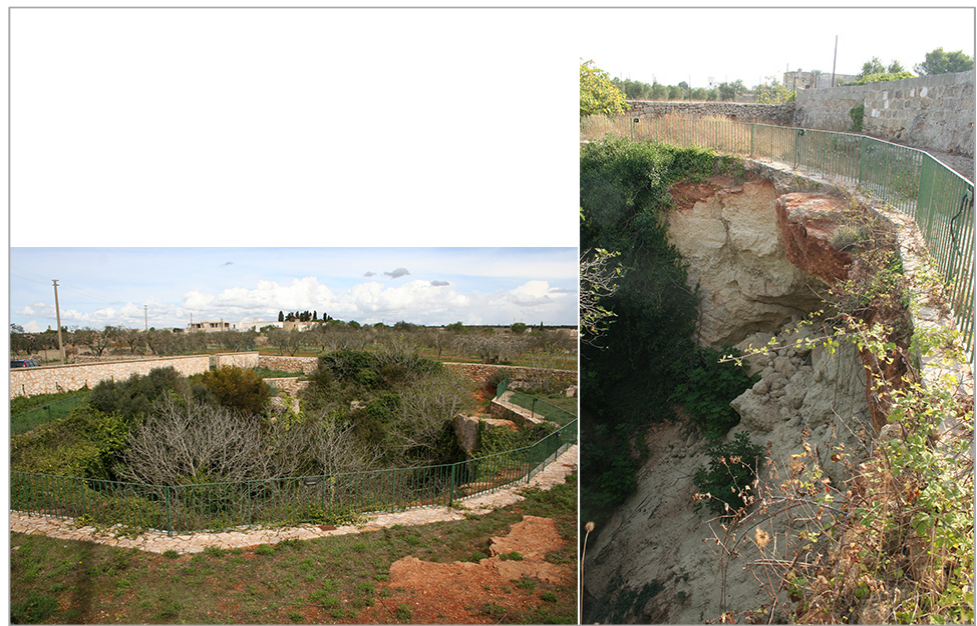
Figure 4. Left: karst collapse sinkhole at Barbarano, Apulia; the sinkhole is 35 mt deep and more than 40 mt wide. Right: detachment of the southern rim of the sinkhole as a reactivation in February 2011.